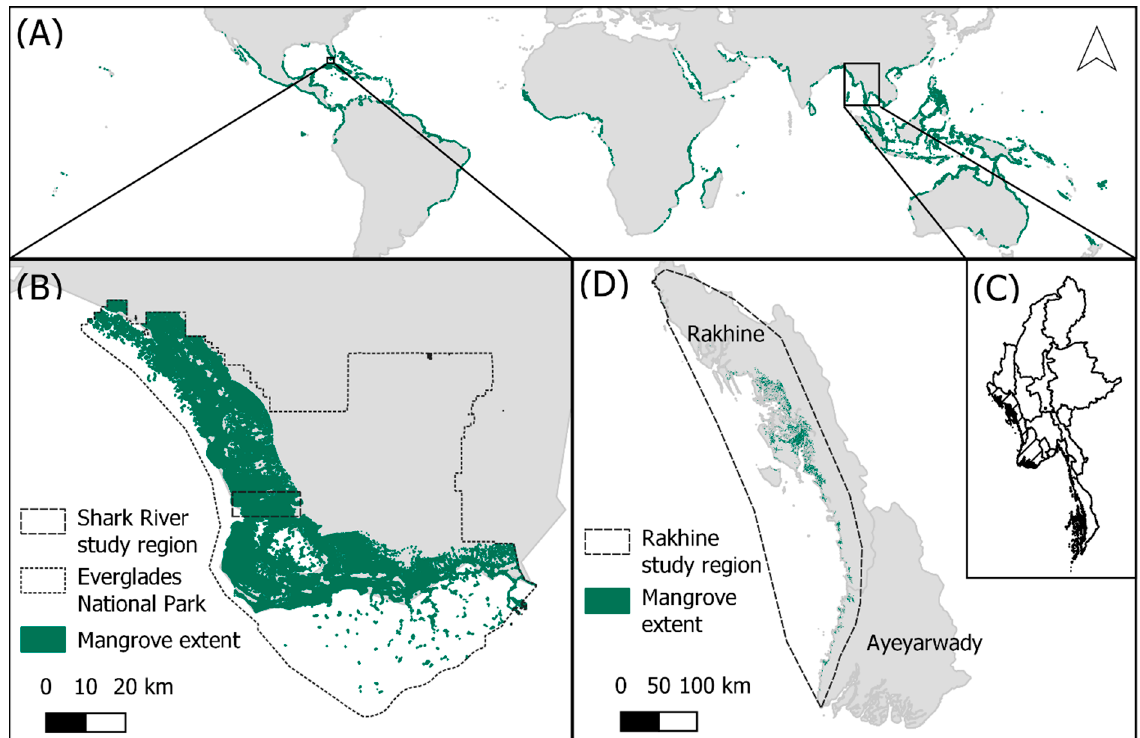
Figure 1. ( A ) Global mangrove extent from the Global Mangrove Watch 2016 dataset. ( B ) Case study region around Shark River within the Everglades National Park in Florida. ( C ) The location of Rakhine and Ayeyarwady states (line-shaded) within Myanmar. ( D ) Case study region for Rakhine mangroves along the coast of the Rakhine state and far west coast of Ayeyarwady up to Cape Negrais.